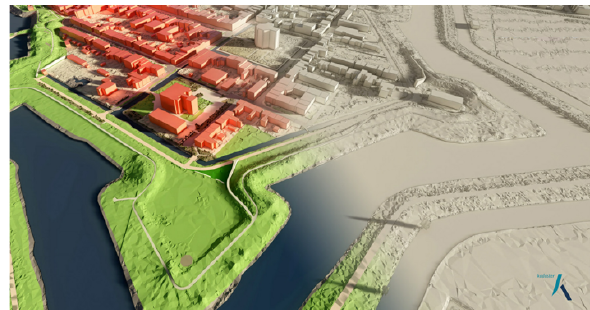
Figure 5: Visualisation of 3D Basisbestand Volledig as available from